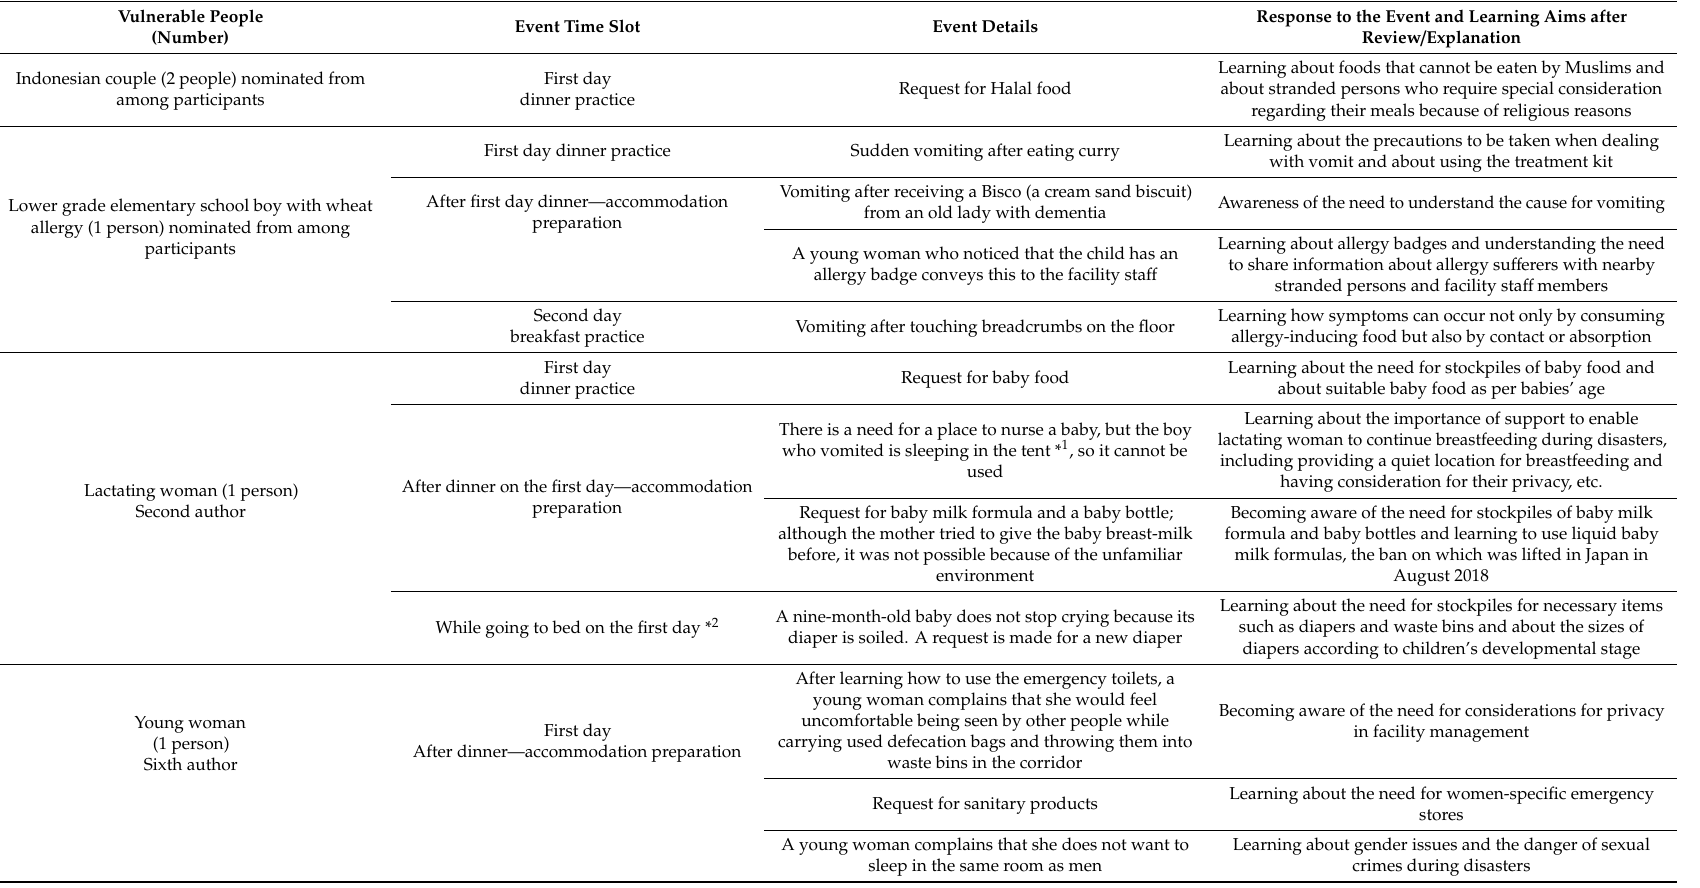
Table 2. Details of the main events during the role-play related to seven vulnerable